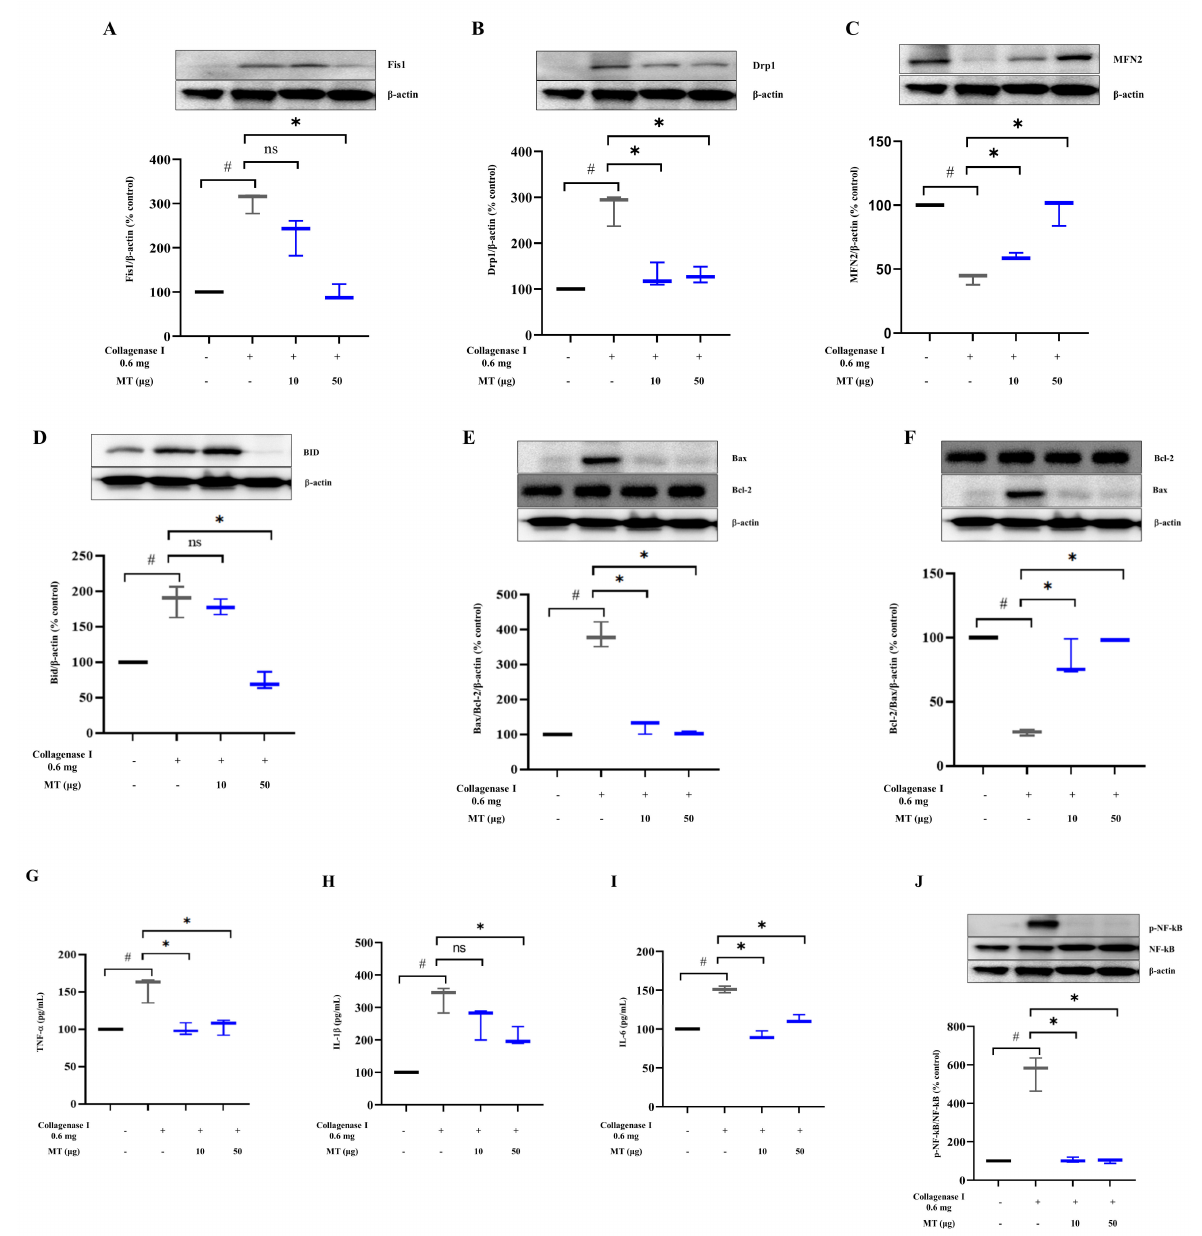
Figure 5. Effect of mitochondrial transplantation on mitochondrial dynamics and apoptosis- and inflammation-related marker levels in collagenase-induced tendinopathy in rats in vivo. ( A – C ): changes in levels of mitochondrial fission markers such as Fis1 and Drp1 and the fusion marker MFN2. Representative western blots and densitometric quantification of ( A ) Fis1, ( B ) Drp1, and ( C ) MFN2; ( D – F ): Effects on apoptosis-related markers BID, Bax, and Bcl-2. Representative western blots and densitometric quantification of ( D ) BID, ( E ) Bax, and ( F ) Bcl-2; third-row panel ( G – I ) shows that mitochondrial transplantation decreased the levels of inflammatory markers such as ( G ) TNF- α , ( H ) IL-1 β , and ( I ) IL-6, as determined using ELISA. Representative western blot and densitometric quantification of ( J ) NF- κ B signaling; ( A – F ) and ( J ): β -actin as a loading control. Data represent mean ± standard deviation (SD) ( n = 3). # p < 0.05 between collagenase (+) group (black) and collagenase ( − ) group as control (white), * p < 0.05 between MT (+) group damaged by collagenase (gray) and MT ( − ) group damaged by collagenase (black) MT, mitochondria; Fis1, Fission 1; Drp1, dynamin-related protein 1; MFN2, mitofusin 2; BID, BH3-interacting domain death agonist; Bax, Bcl-2 associated X; Bcl-2, B-cell lymphoma 2; TNF- α , tumor necrosis factor- α ; IL, interleukin; NF- κ B, nuclear factor-kappa B; ELISA, enzyme-linked immunosorbent